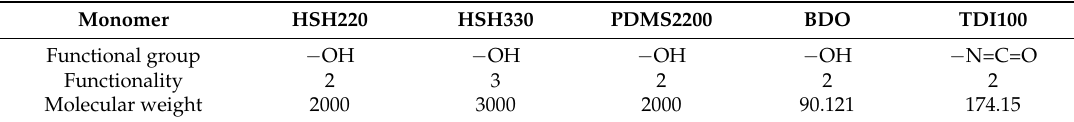
Table 1. The characteristics of monomers.